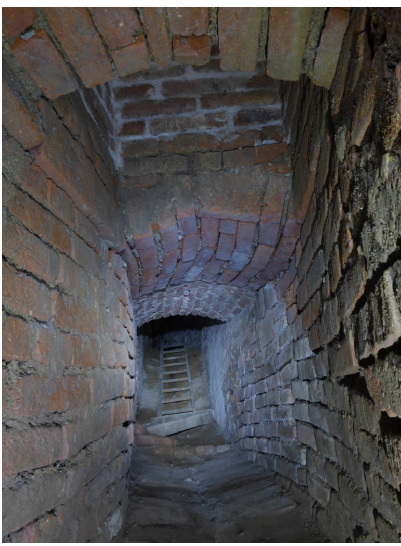
Figure 7. Carmel Monastery: reconstructed main